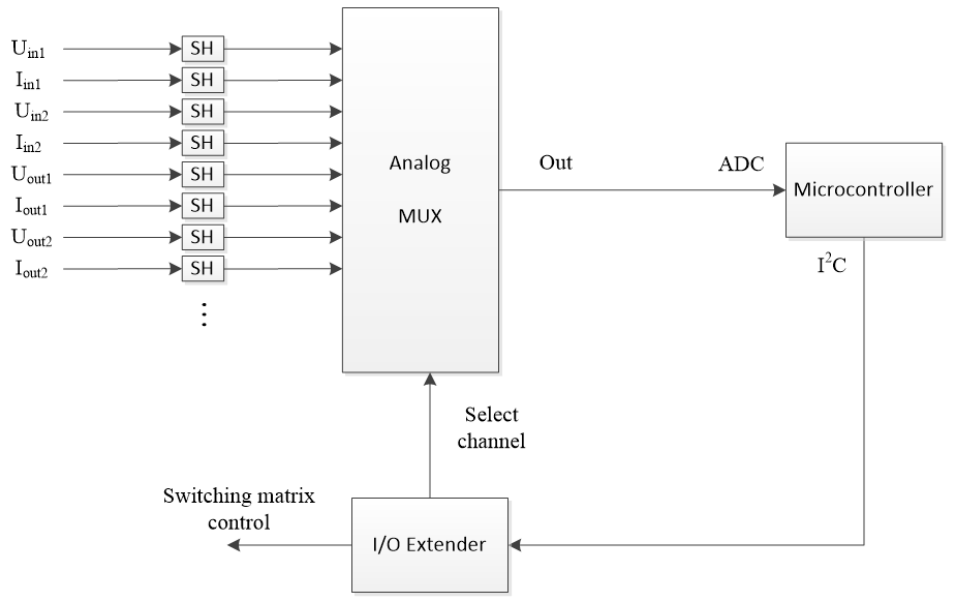
Figure 7. Hardware measurement and control scheme.